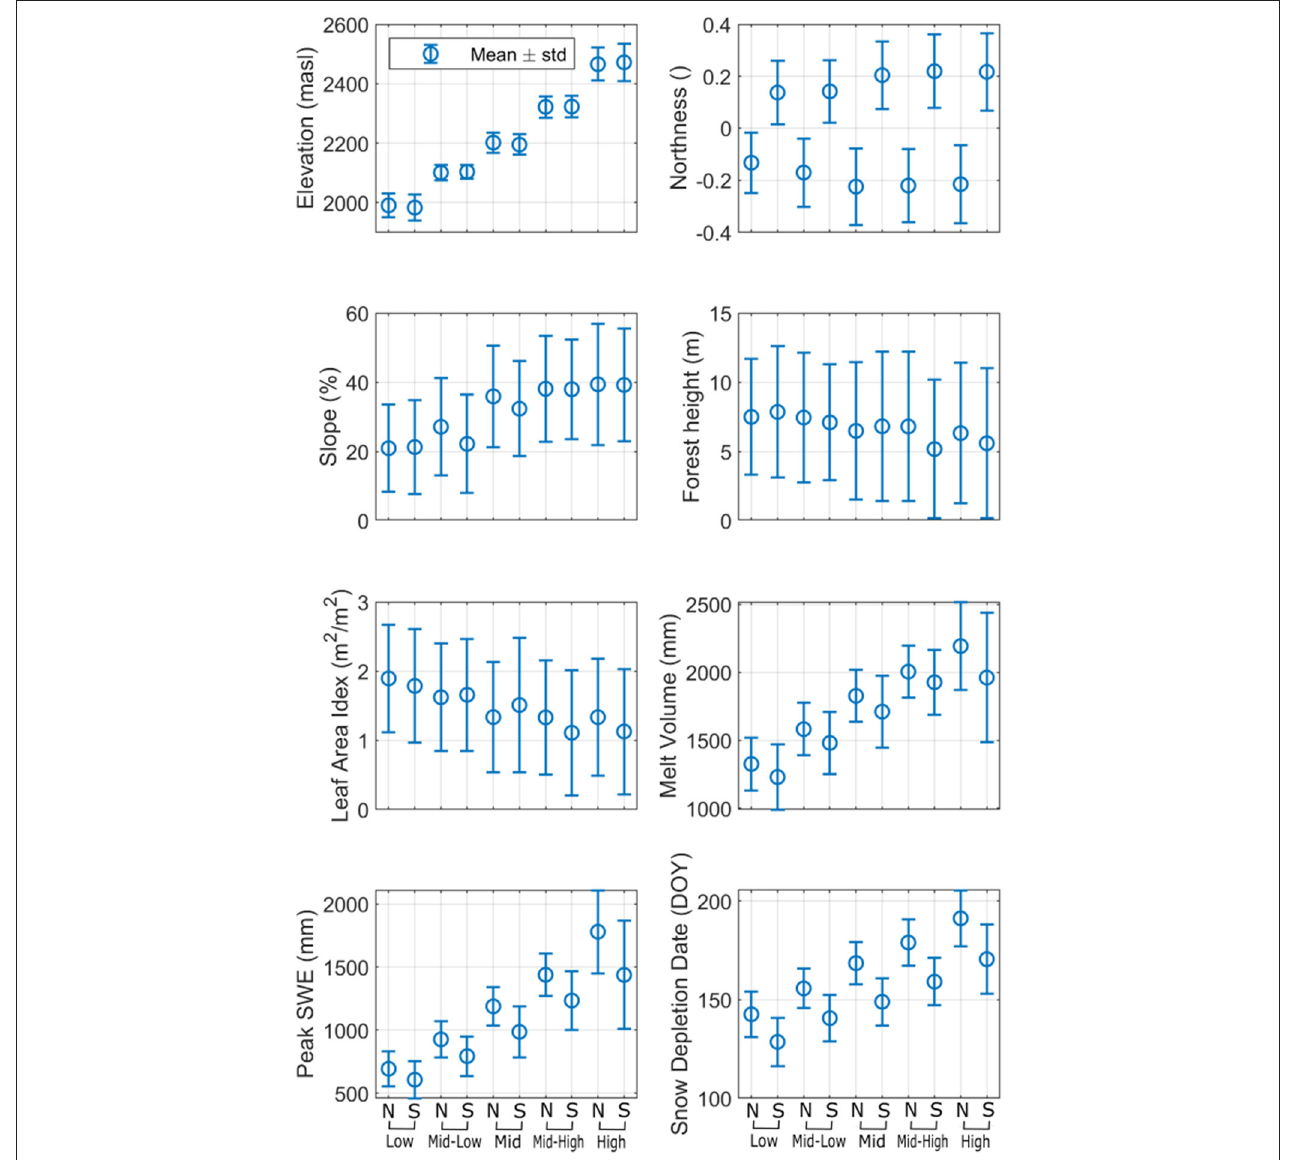
FIGURE 2 | Mean ( ± standard deviation) Snow Zones’ topography, vegetation and snow conditions for the water years 2016–2018 as simulated by SnowPALM. Values for forest LAI and height include non-vegetated areas within each Snow Zone. “N” and “S” on the x-axis represent north- and south-facing Snow